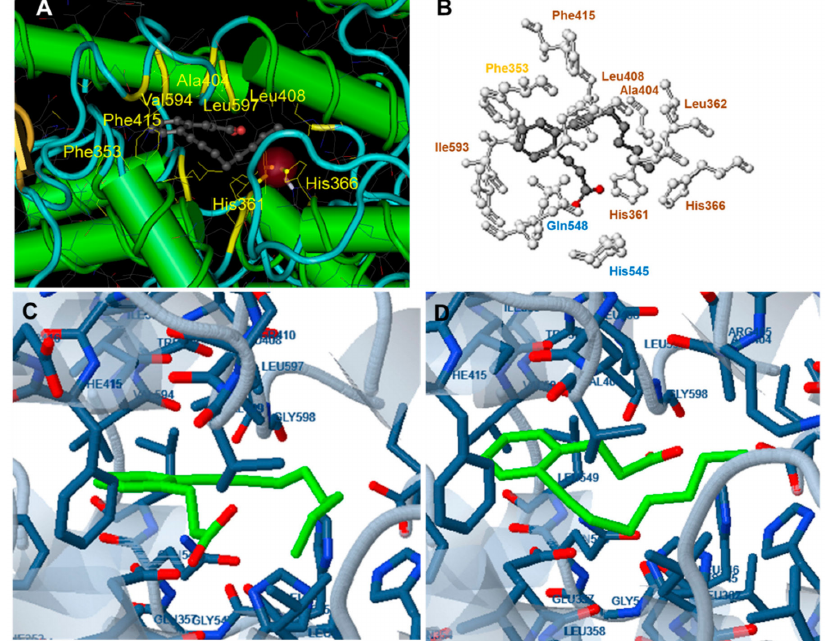
Figure 4. ( A ) The reference compound 3-(2-oct-1-ynylphenyl) propanoic acid (OPPA) in complex with 1LOX; ( B , D ) Docking of OPPA to 1LOX (target box 35). The orientation of the compound is analogue to the original complex (In B. blue: polar interactions, brown: hydrophobic interactions, yellow: pi interactions). In the complex of 1LOX with OPPA (box 35), the carboxylic group of the ligand participates in polar interactions with Gln548 and His545. Hydrophobic interactions with His361, His366, Leu362 Ala404, Leu408 and Phe415 are observed while pi-pi interactions between Phe353 and carbon atoms of the phenyl ring of the ligand also take place; ( C ) Docking of OPPA to 1LOX (target box 30). The compound occupies an opposite orientation to than in the original